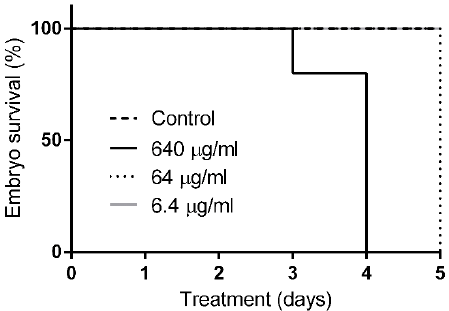
Figure 4. Toxicity of Q22 in the zebrafish embryo model . Zebrafish embryos were exposed to increasing concentrations of Q22 (6.4 μ g/mL; 64 μ g/mL; 640 μ g/mL) at 30 high power field and monitored for survival for up to 120 h post-incubation. Data expressed as percentage survival.